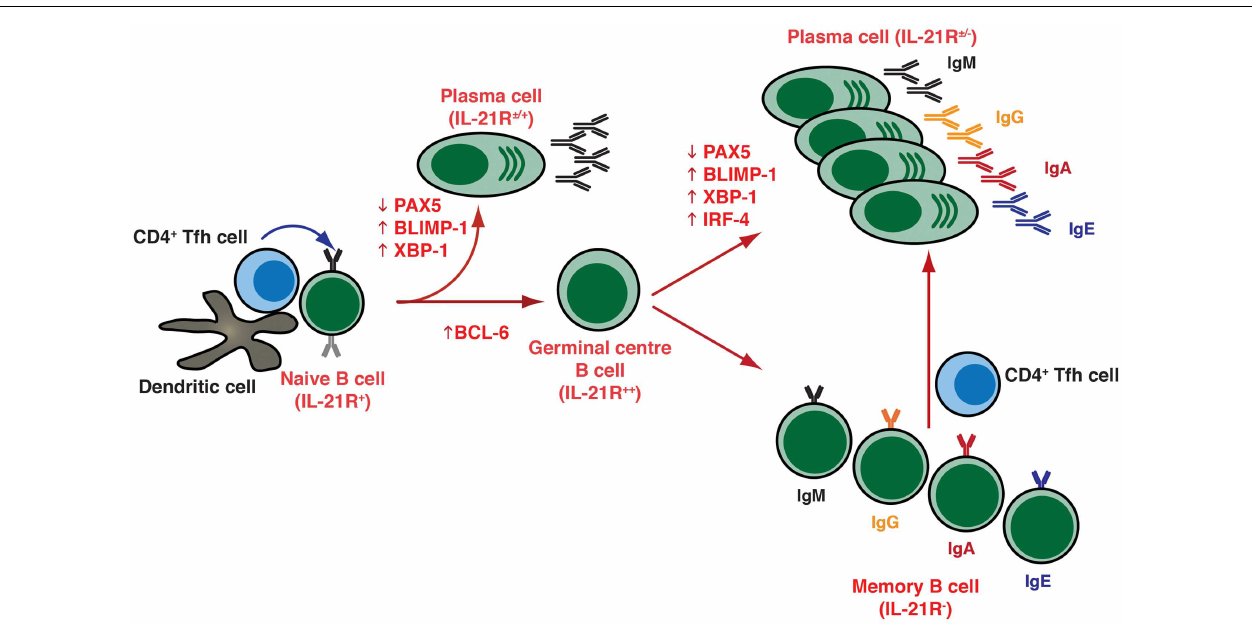
including the switched isotypes IgG, IgA, and IgE.The outcome of the GC reaction is heavily influenced byTfh cells, especially those within the GC itself.These cells are not depicted on the figure but they contribute greatly at this stage of B-cell differentiation. Following re-encounter with the initiating Ag, memory B cells rapidly differentiate into plasma cells.The differentiation of naïve B cells to these distinct effector fates is controlled by the balanced expression and regulated function of various transcription factors, including (but not exclusively) PAX5, BCL-6, BLIMP-1, XBP-1, and